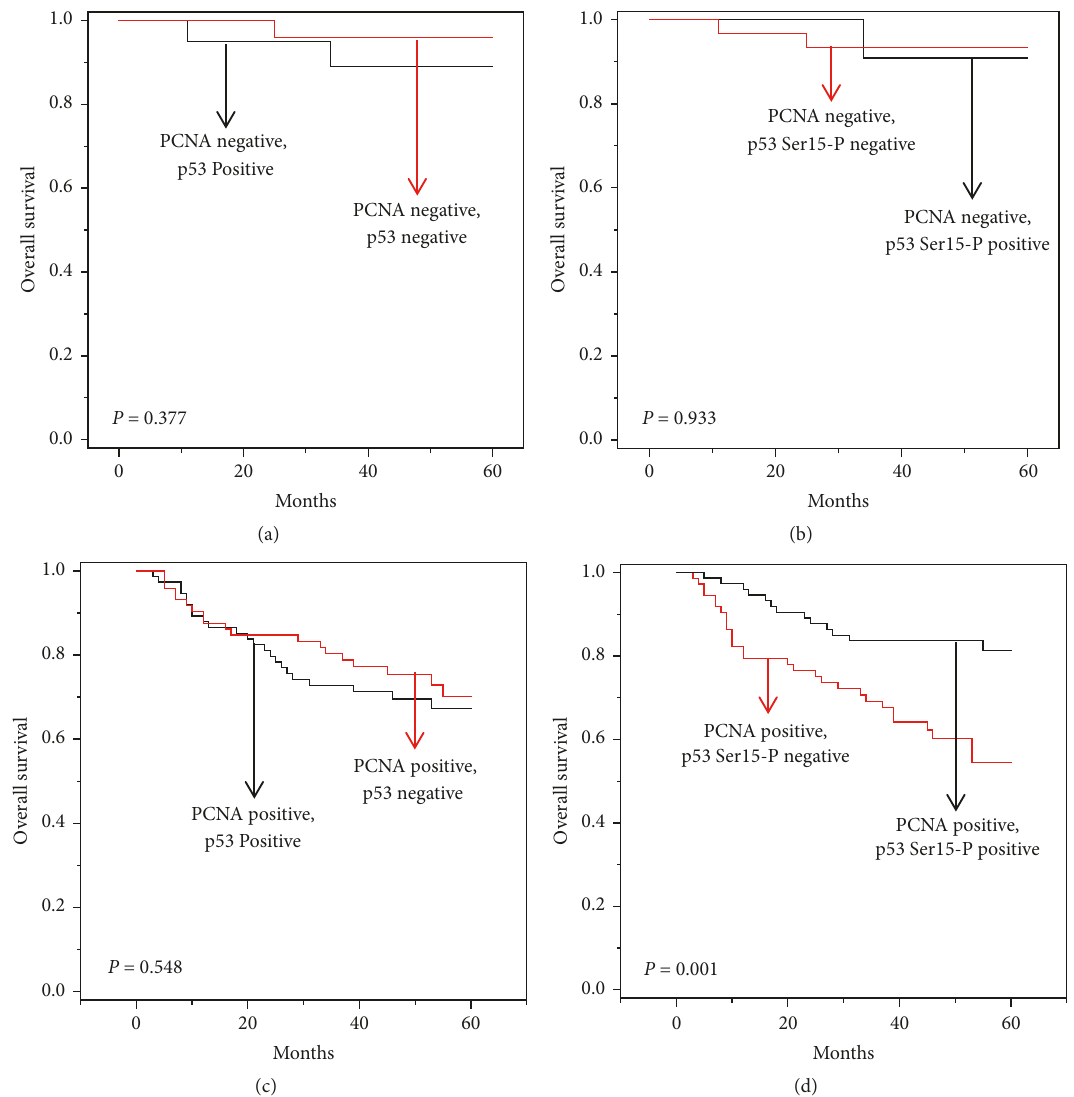
Figure 3: Five-year overall survival (OS) curves of PCNA-positive or –negative HCC patients with positive or negative expression of p53, and p53 Ser15-P by Kaplan-Meier Curve . (a, b) OS graphs of the PCNA-negative individuals. (a) OS graph of PCNA-negative and p53-positive and -negative individuals. Black line is p53 positive, and red line is p53 negative. (b) OS graph of PCNA-negative and p53 Ser15-P–positive and –negative individuals. Black line is p53 Ser15-P–positive and red line is p53 Ser15-P–negative. (c, d) OS graphs of PCNA-positive population. (c) OS graph of the PCNA-positive and p53-positive and -negative individuals. Black line is p53 positive, and red line is p53 negative. (d) OS graph of the PCNA-positive and p53 Ser15-P–positive and –negative individuals. Black line is p53 Ser15-P–positive, and red line is p53 serine 15-P negative. P , P value from log rank